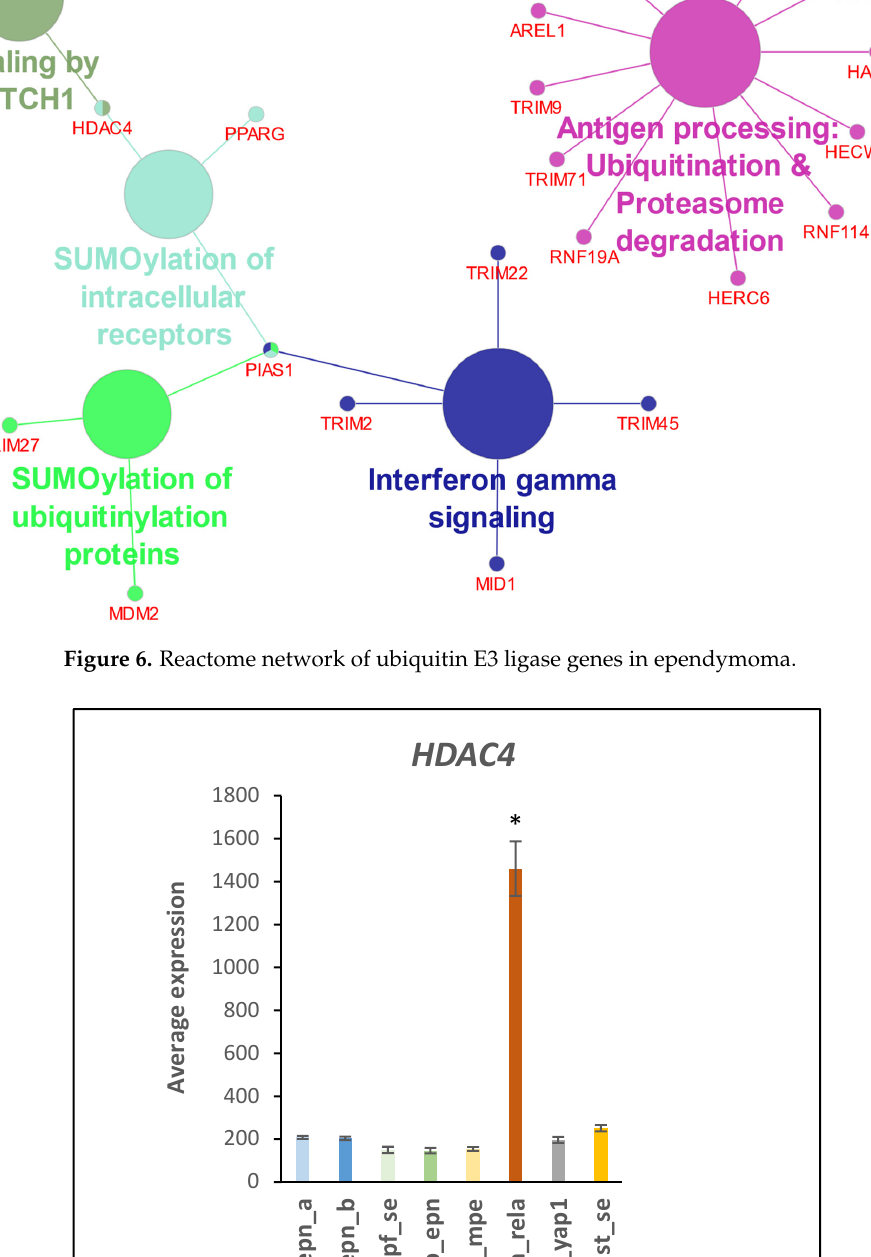
Figure 7. Significantly increased expression of the HDAC4 gene in the ST_EPN_RELA subtype (by Anova, F = 44.88, p = 7.86 × 10 − 38 ). * by t -test significantly different from all other groups p < 0.001. Dataset GSE64415.